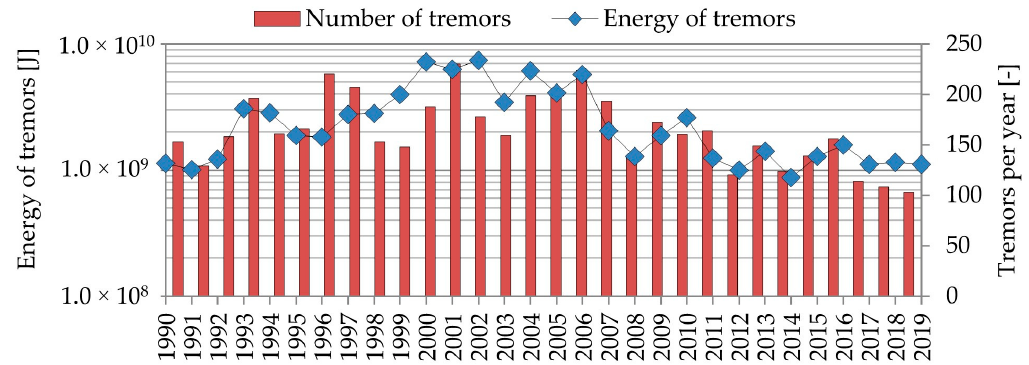
Figure 1. High-energy tremors recorded in the Lower Silesian Copper Basin (LSCB) region since 1991.